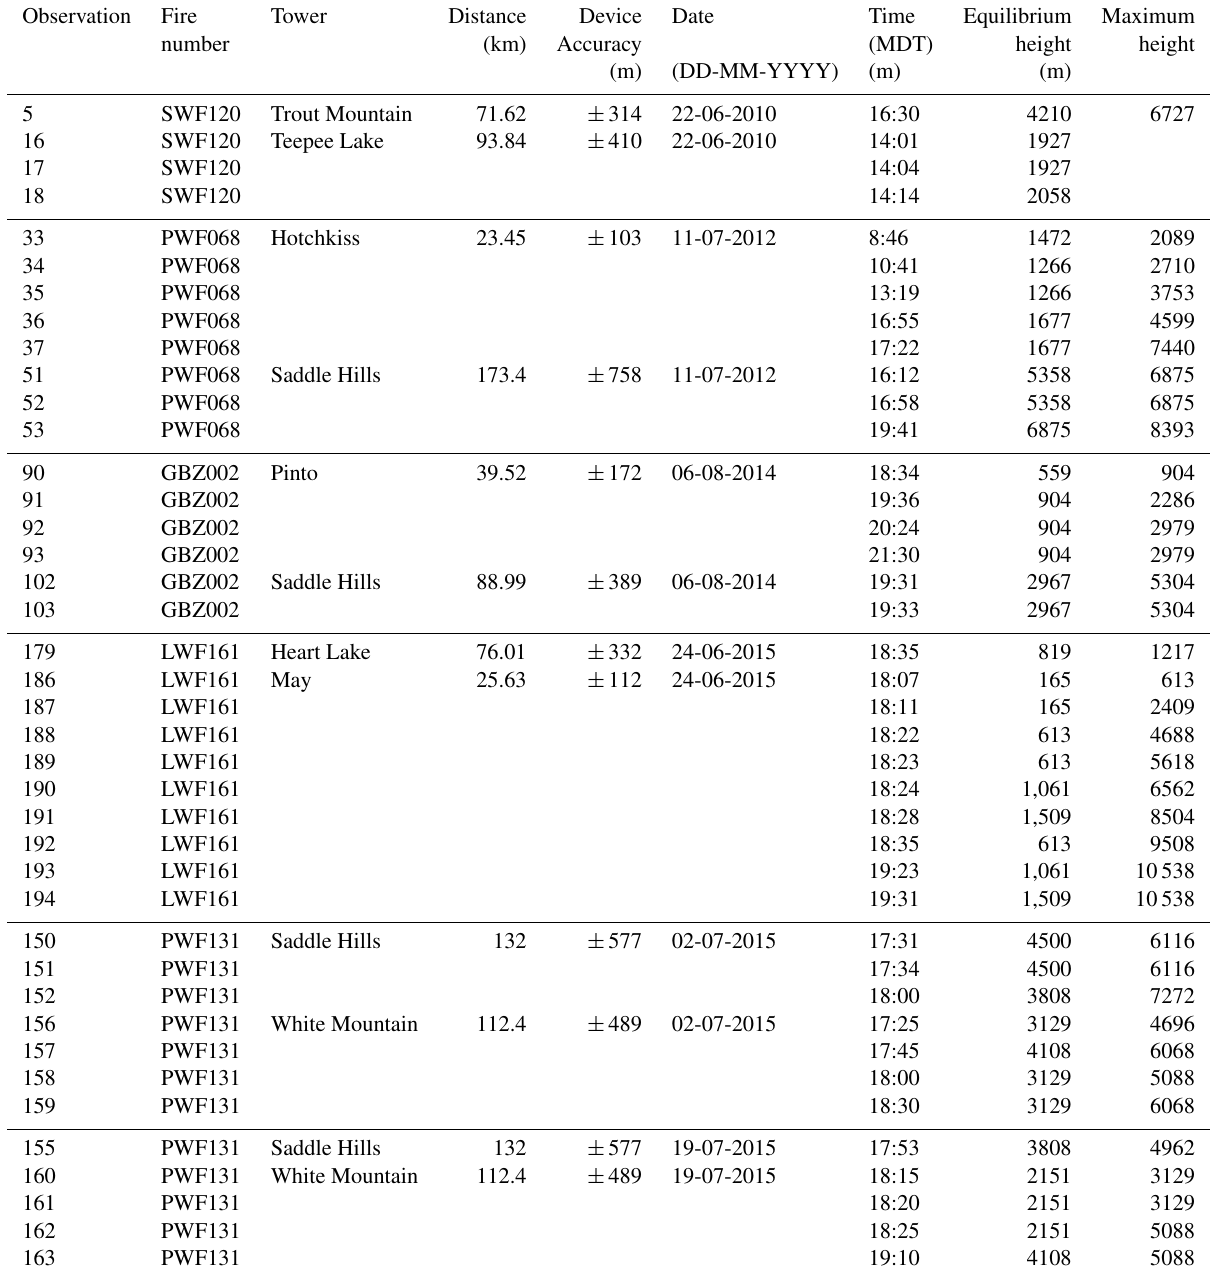
Table 3. Multiple tower